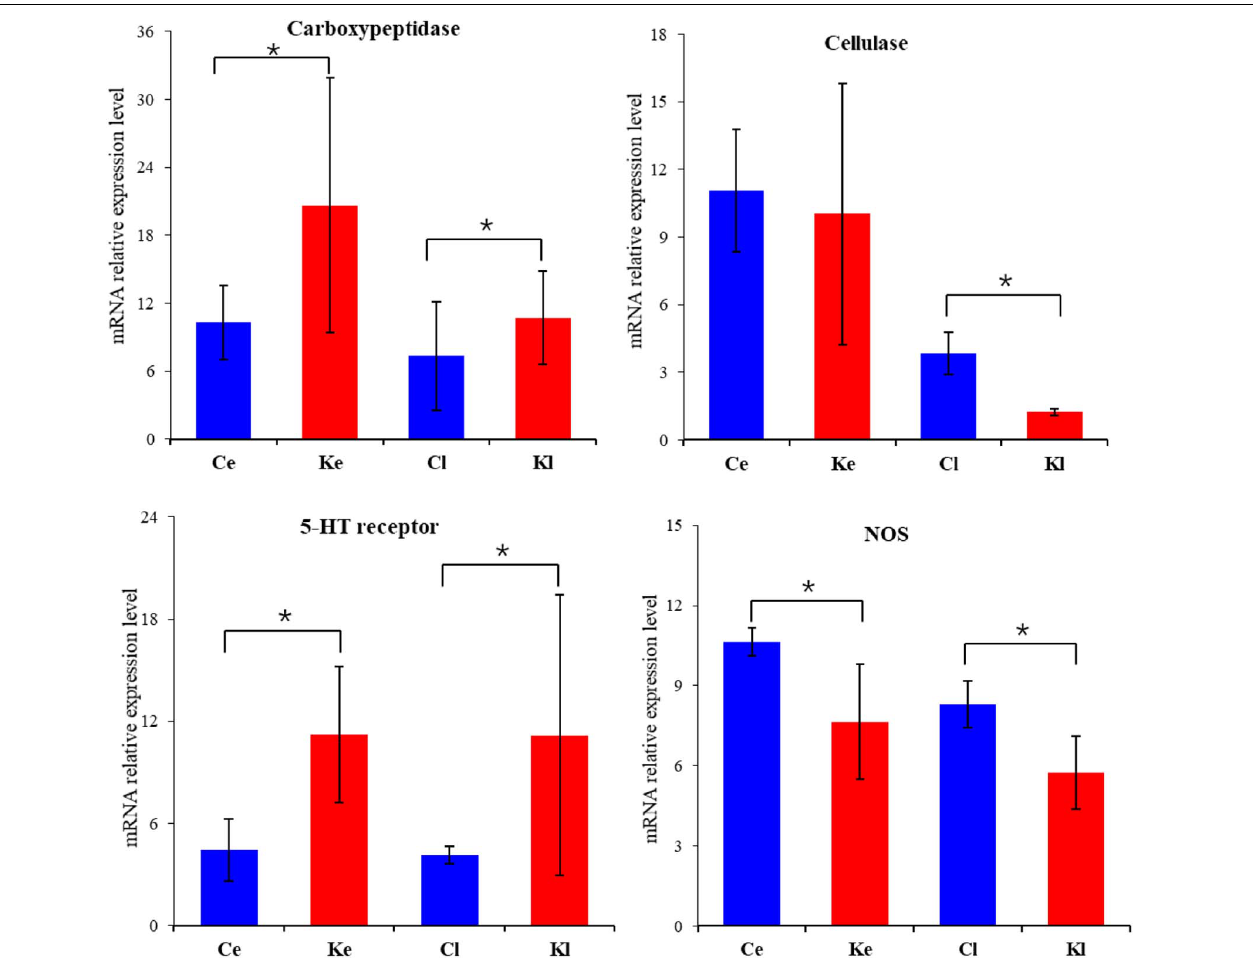
FIGURE 5 | mRNA expression of critical genes (Carboxypeptidase, Cellulase, 5-HT receptor and NOS) in Competent larva induced by CCK (mean ± SE, n = 3). (Different superscript letters indicate significant differences, * P < 0.05). [Ce: Control (early, 2 h), Cl: Control (later, 12 h), Ke: CCK Induction (early, 2 h), Kl: CCK Induction (later, 12